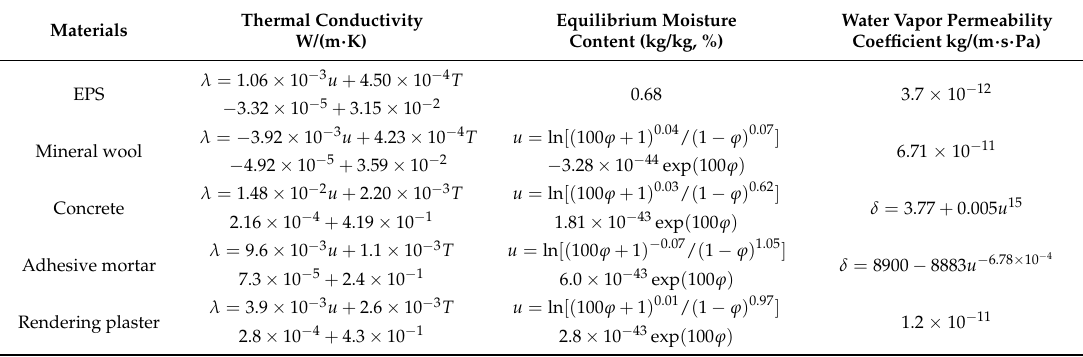
Table 2. Some dynamic hygrothermal properties of building materials.